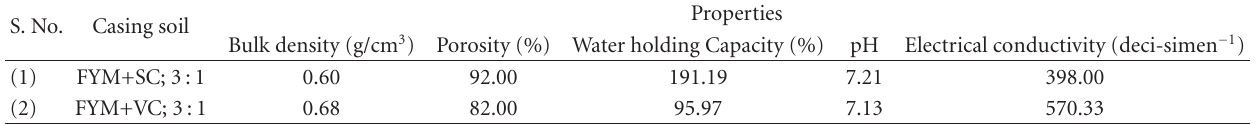
Table 1: Physicochemical properties of casing mixtures.